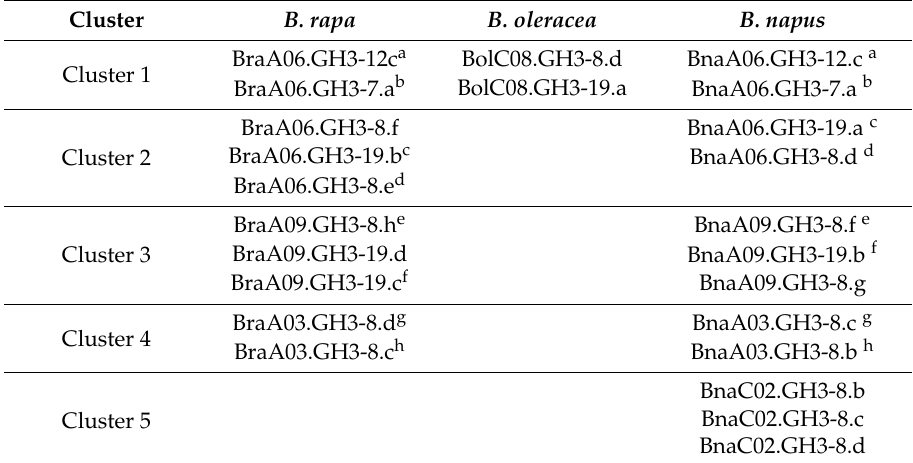
Table 3. The clusters of GH3 tandem repeat genes in the three species of Brassica